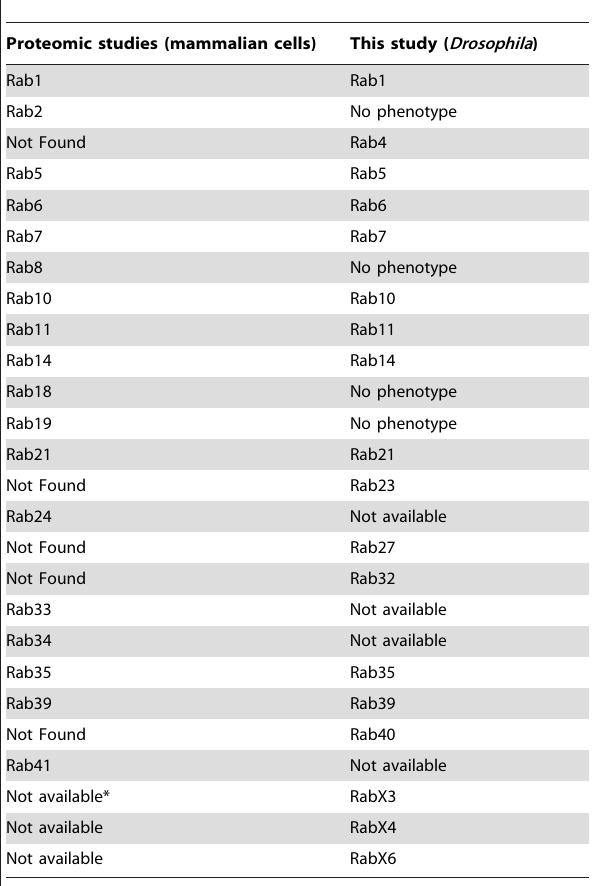
Table 1. Comparison of Rabs identified in this study with previous proteomic studies [13,14].